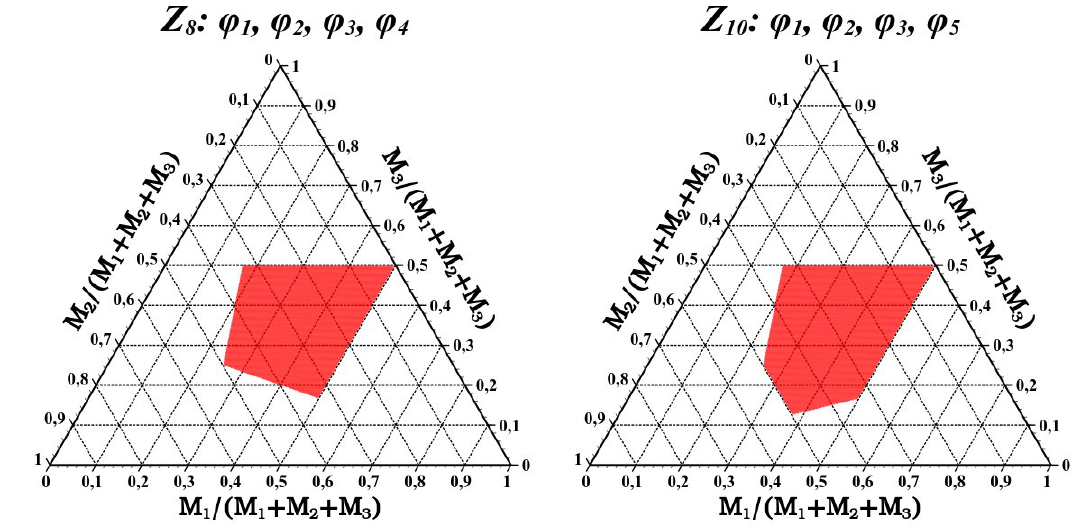
Figure 8 . The region where four (cid:12)elds can be stable for a Z 8 symmetry with (cid:12)elds (cid:30) 1 ; (cid:30) 2 ; (cid:30) 3 ; (cid:30) 4 (left) and for a Z 10 symmetry with (cid:12)elds (cid:30) 1 ; (cid:30) 2 ; (cid:30) 3 ; (cid:30) 5 (right). For each point inside the colored region, it is possible to (cid:12)nd values of M 0 (left) or M 0 (right) such that all four (cid:12)elds are 4 5